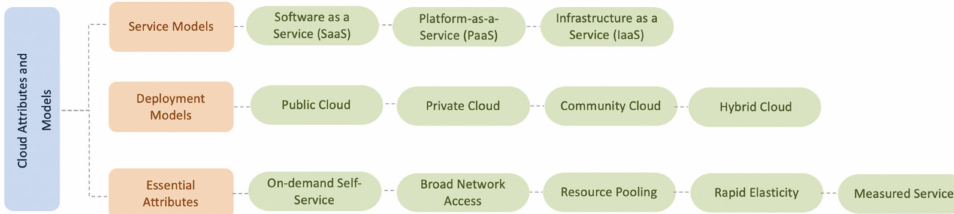
Figure 4. Cloud attributes and models.